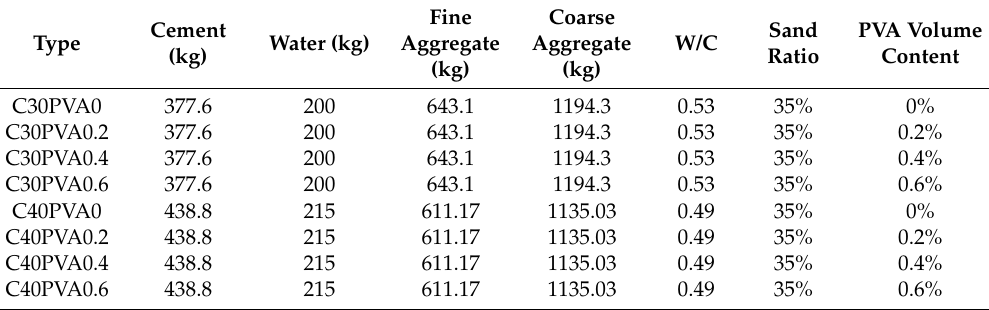
Table 3. Mix proportions of fiber-reinforced concrete (FRC) (1 m 3 ).